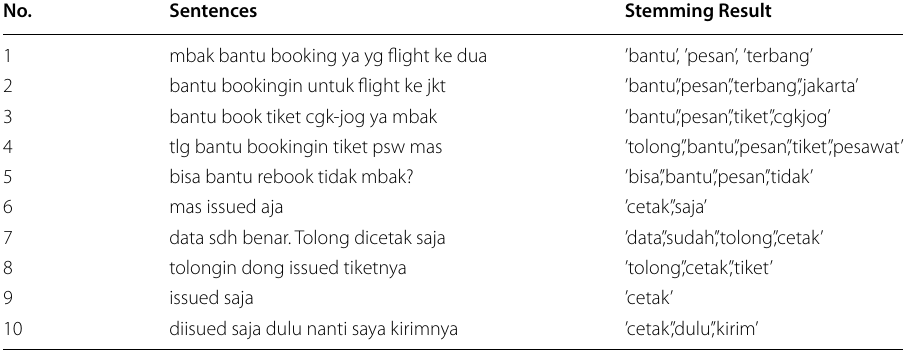
Table 4 The result of stemming by using “Incorbiz” No.